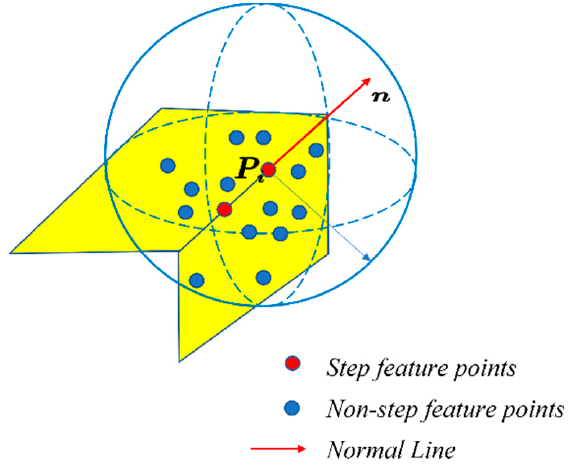
Figure 6. Step-feature-point detection.